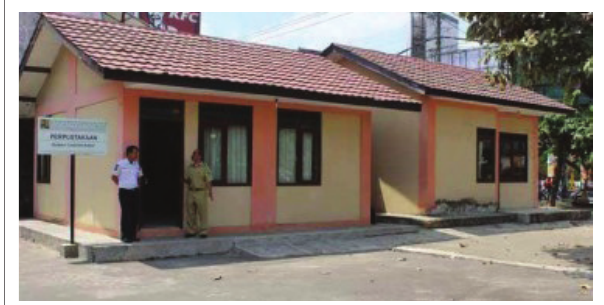
Source : Photo courtesy of the Indonesia Government Trough Residential Research and Development Center 2017. FIGURE 9: Example of Simple Instant Healthy House.